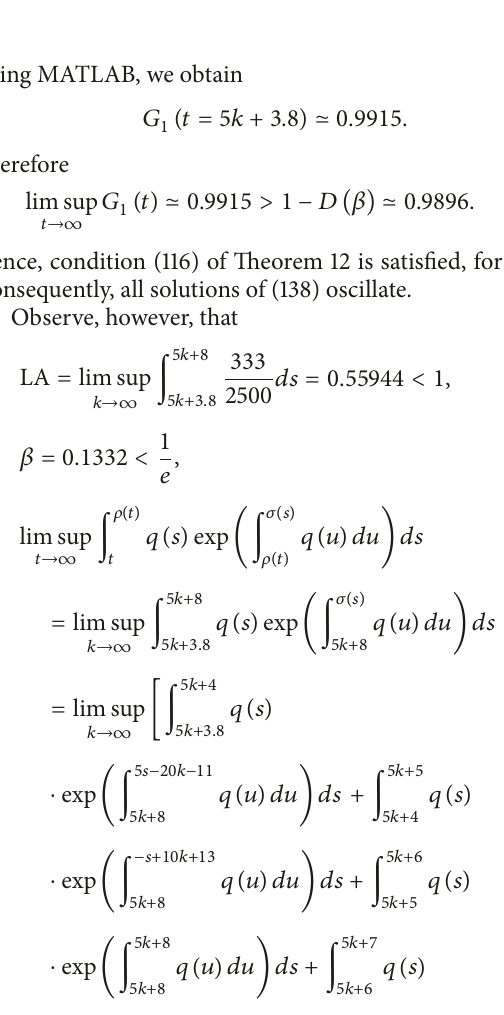
Figure 2: The graphs of 𝜎(𝑡) and 𝜌(𝑡)